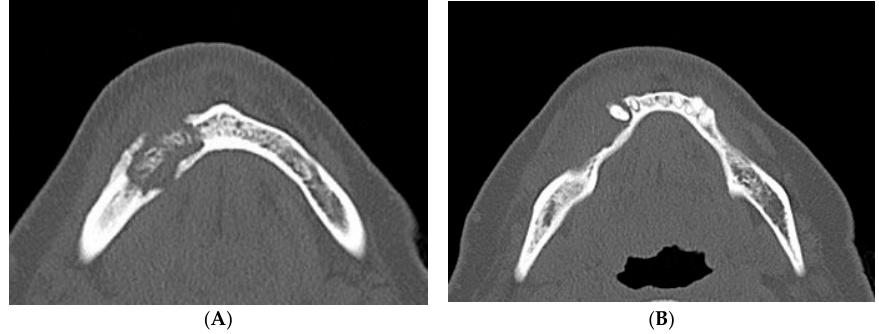
Figure 6. ( A , B ) Computed tomography (CT) scan dated February 2015, which showed a large sequestrum in right mandible along with erosion of the buccal and lingual cortical plates. In the left maxillary, a large area of bone rarefaction and erosion extending from the area of cuspid to second premolar was observed (Figure 7).